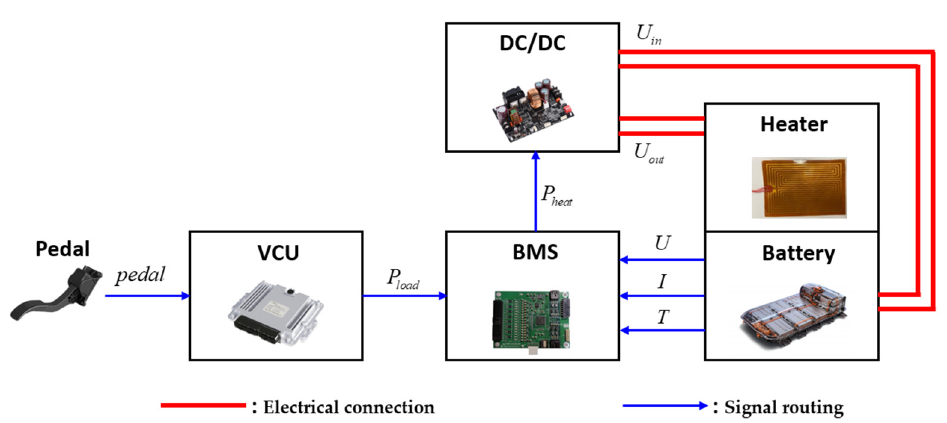
Figure 2. Block diagram of the battery external heating system.